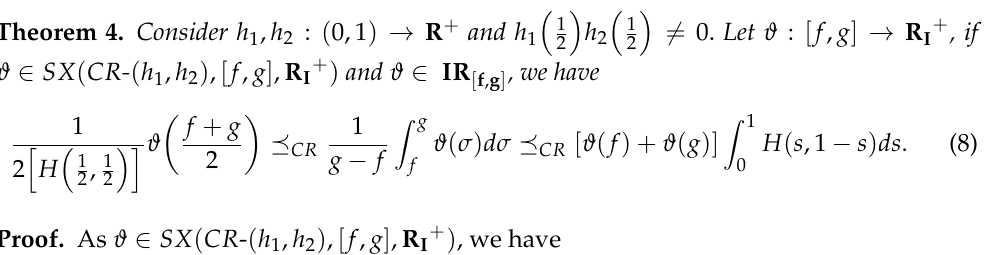
Figure 4. As shown in the example above, ϑ is shown as a red and ϑ as a yellow line, respectively. Next, we will establish H−H inequality for CR- ( h 1 , h 2 ) -convex function. In what follows, let H ( x , y ) = h 1 ( x ) h 2 ( y )